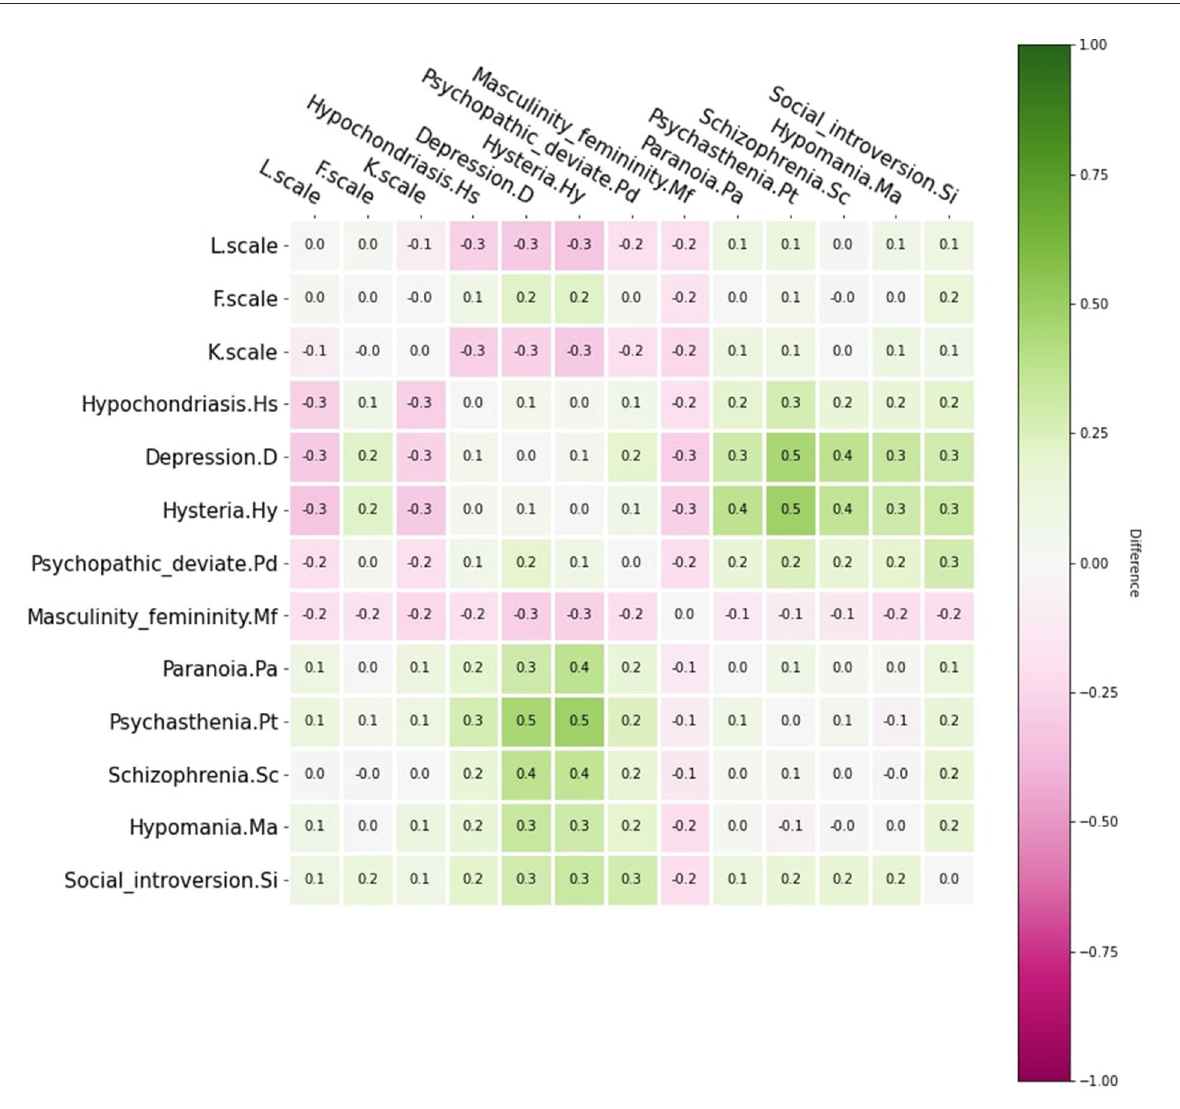
FIGURE3 MMPI-2 scales correlation matrix difference between healthy people and patients with